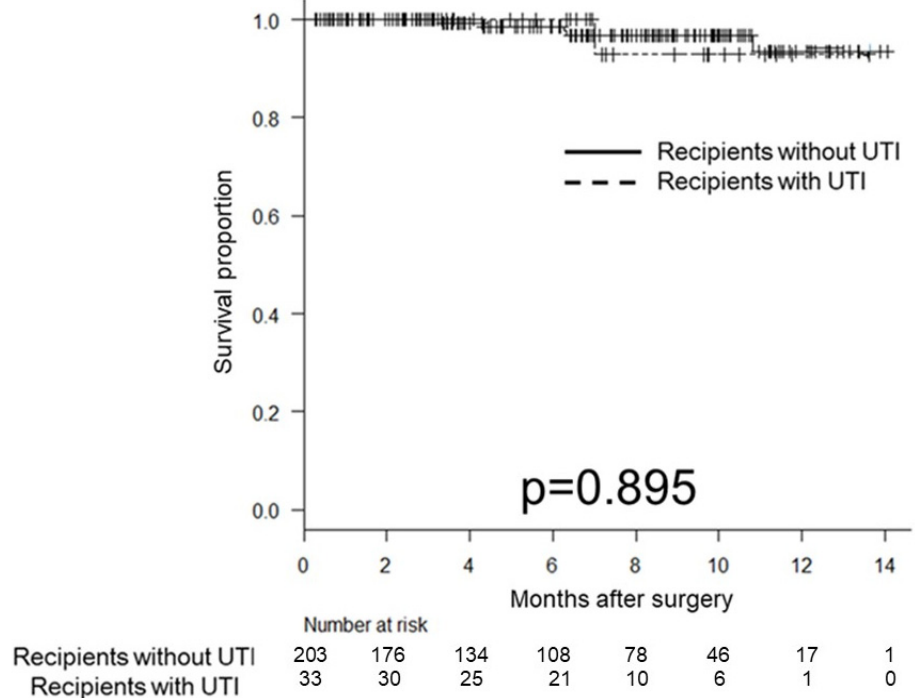
Figure 1. Kaplan–Meier estimates of graft survival according to urinary tract infection (UTI) after kidney transplantation (KT); the 5-year graft survival was 98.6% in KT patients without UTI and 100% in KT patients with UTI ( p = 0.895).